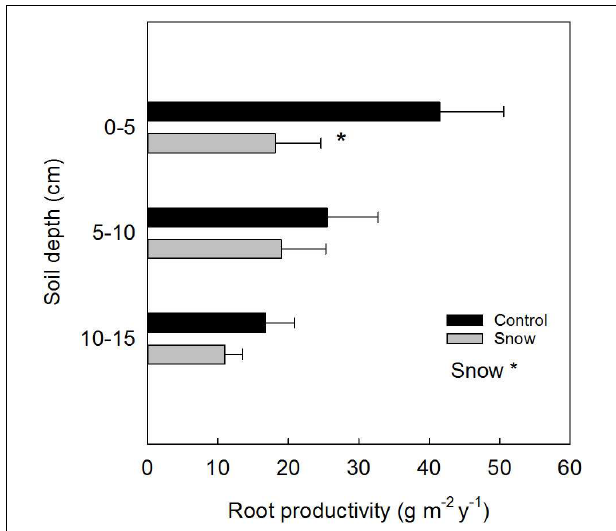
FIGURE 3 | Relative depth-specific fine root productivity (mean ± SE) estimated from ingrowth bags placed at control and at snow accumulation plots ( n = 6). Significant treatment effects are indicated by a ∗ P ≤